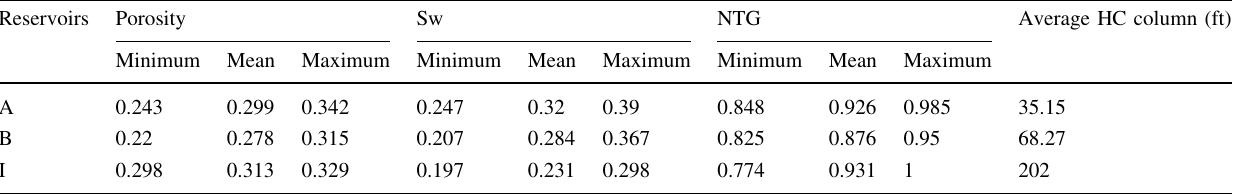
Table 2 Summary of the petrophysical parameters used for the volumetric Reservoirs Porosity Sw